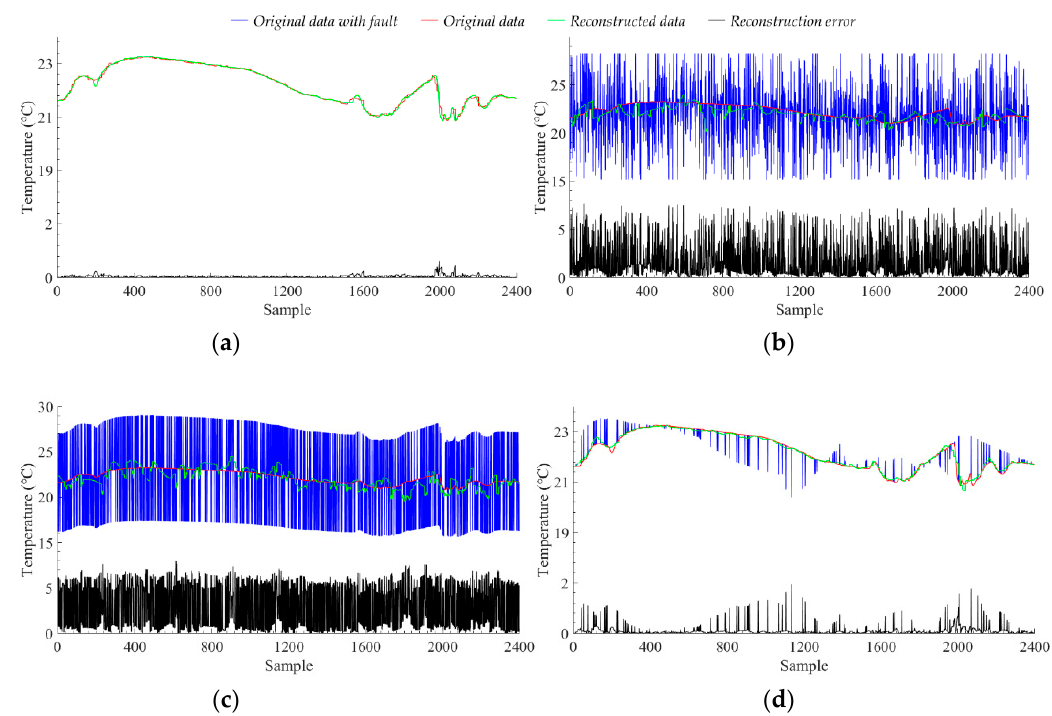
Figure 10. The data reconstruction results of the model for different data faults. ( a ) The original data without fault, ( b ) The original data with noise fault and the ratio of fault data is 50%, ( c ) The original data with short-term fault and the ratio of fault data is 50%, ( d ) The original data with fixed fault and the ratio of fault data is 5%.